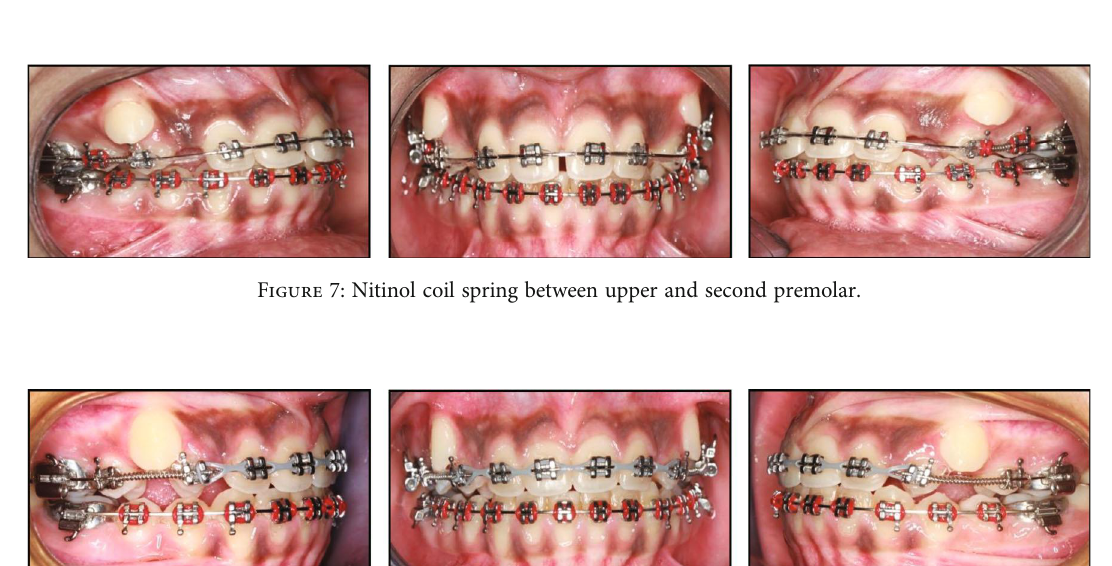
Figure 6: Banding and bonding (upper and lower preadjusted edgewise fi xed appliances with MBT prescription and 0 : 022 ″ × 0 : 028 ″ slot size bracket) and placement of the initial leveling and aligning archwires (0.014 superelastic nickel titanium).